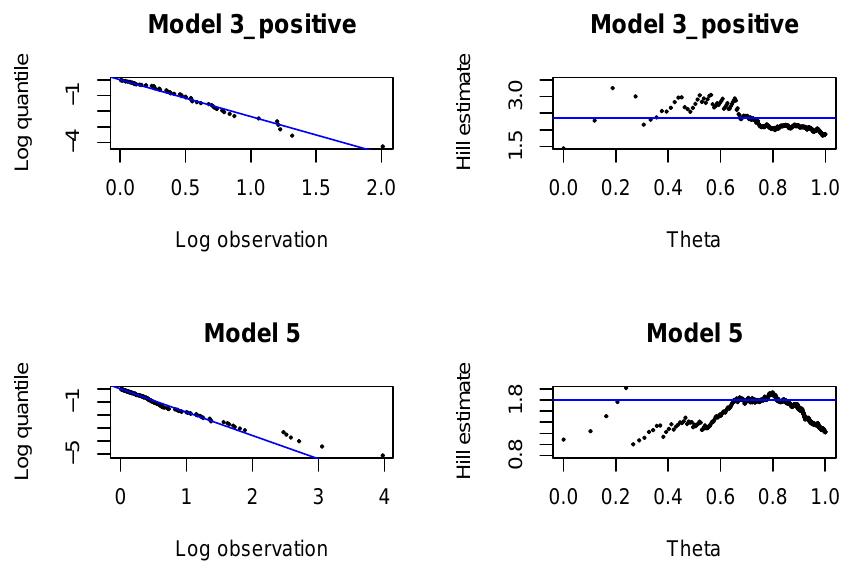
Figure A5. Pareto quantile plots and altHill plots for incremental payments and changes in claim incurred in k =